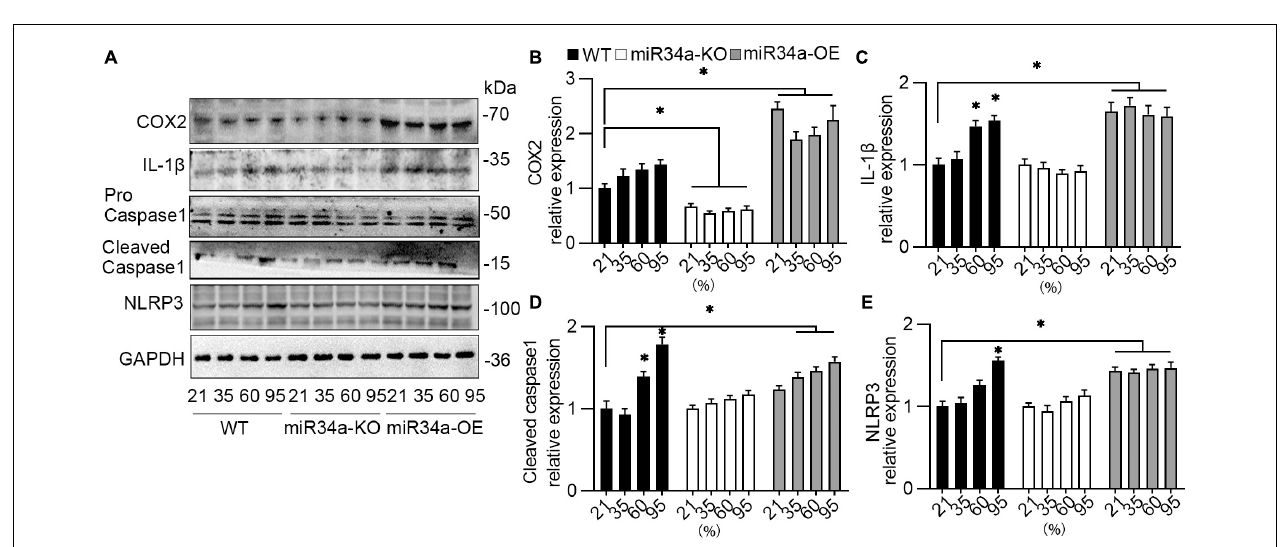
FIGURE 4 | NLRP3 inflammasome pathway was activated by hyperoxia. (A) WT, miR34a-KO, and miR34a-OE A549 cells were collected after to different concentration of oxygen for 72 h, then examined by COX-2, IL-1 β , caspase 1, and NRLP3 antibody using Western blotting and (B–E) their statistical results. One-way ANOVA, ∗ p < 0.05 vs. 21%, n =